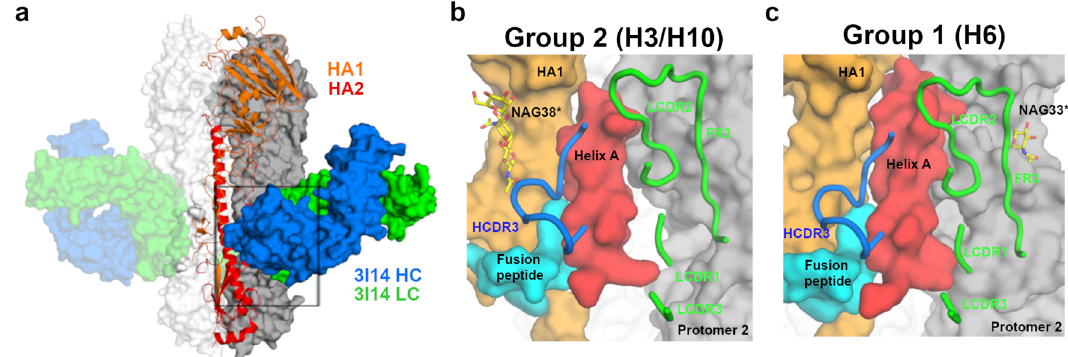
Fig. 1 3I14 recognition of group 1 and group 2 HA proteins. a X-ray structure of H3 hemagglutinin bound by Fab 3I14. One HA protomer is shown in cartoon with HA1 colored orange and HA2 colored red. The other two HA protomers are shown in surface representation and colored white or gray. 3I14 is shown in surface representation with heavy chain colored blue and light chain colored green. b Zoomed in view of the box from a showing the H3-3I14 interface and the major structural elements of HA, which are recognized. Helix A is colored red, the fusion peptide is colored cyan, HA1 is colored orange, and a second HA protomer is colored gray. The 3I14 CDRs are shown as cartoons. A group 2-speci fi c sugar residue at position 38 of HA1 is labeled as NAG38*. c Similar view as in b showing the H6-3I14 D93N interface. A group 1-speci fi c sugar on the second HA protomer, which interacts with 3I14 is labeled as